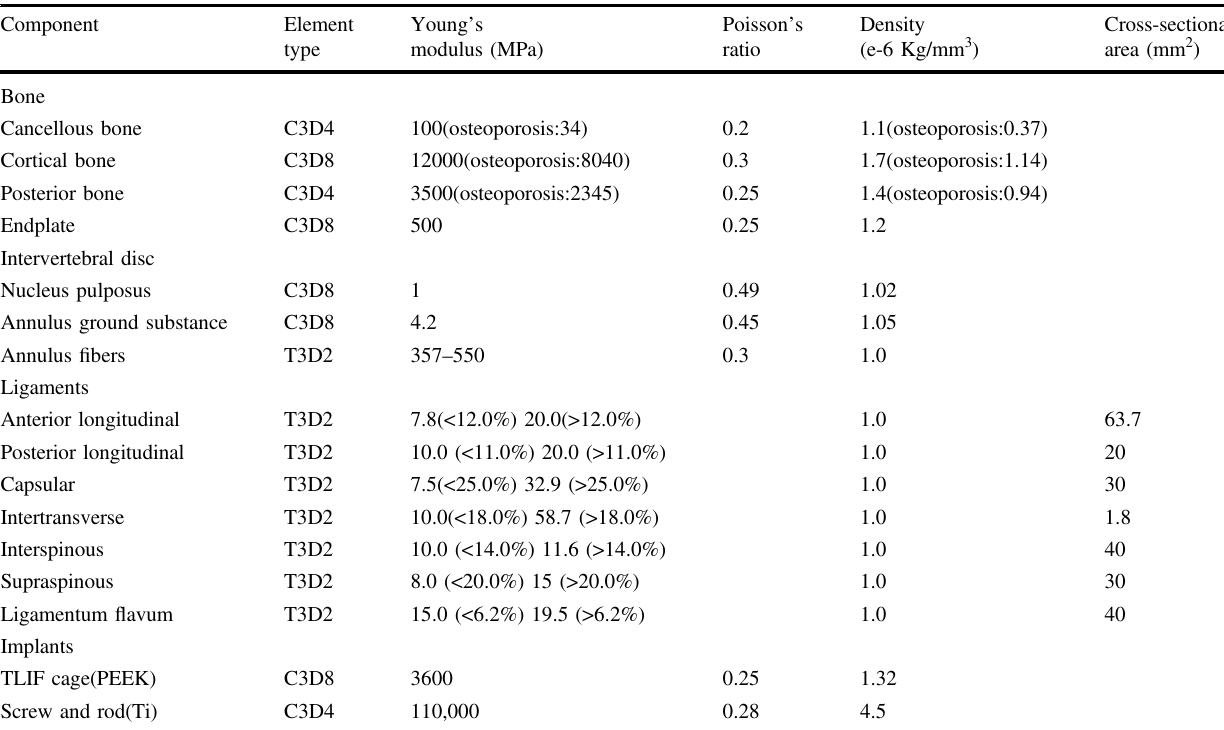
Table 1 Material properties of the fi nite element model